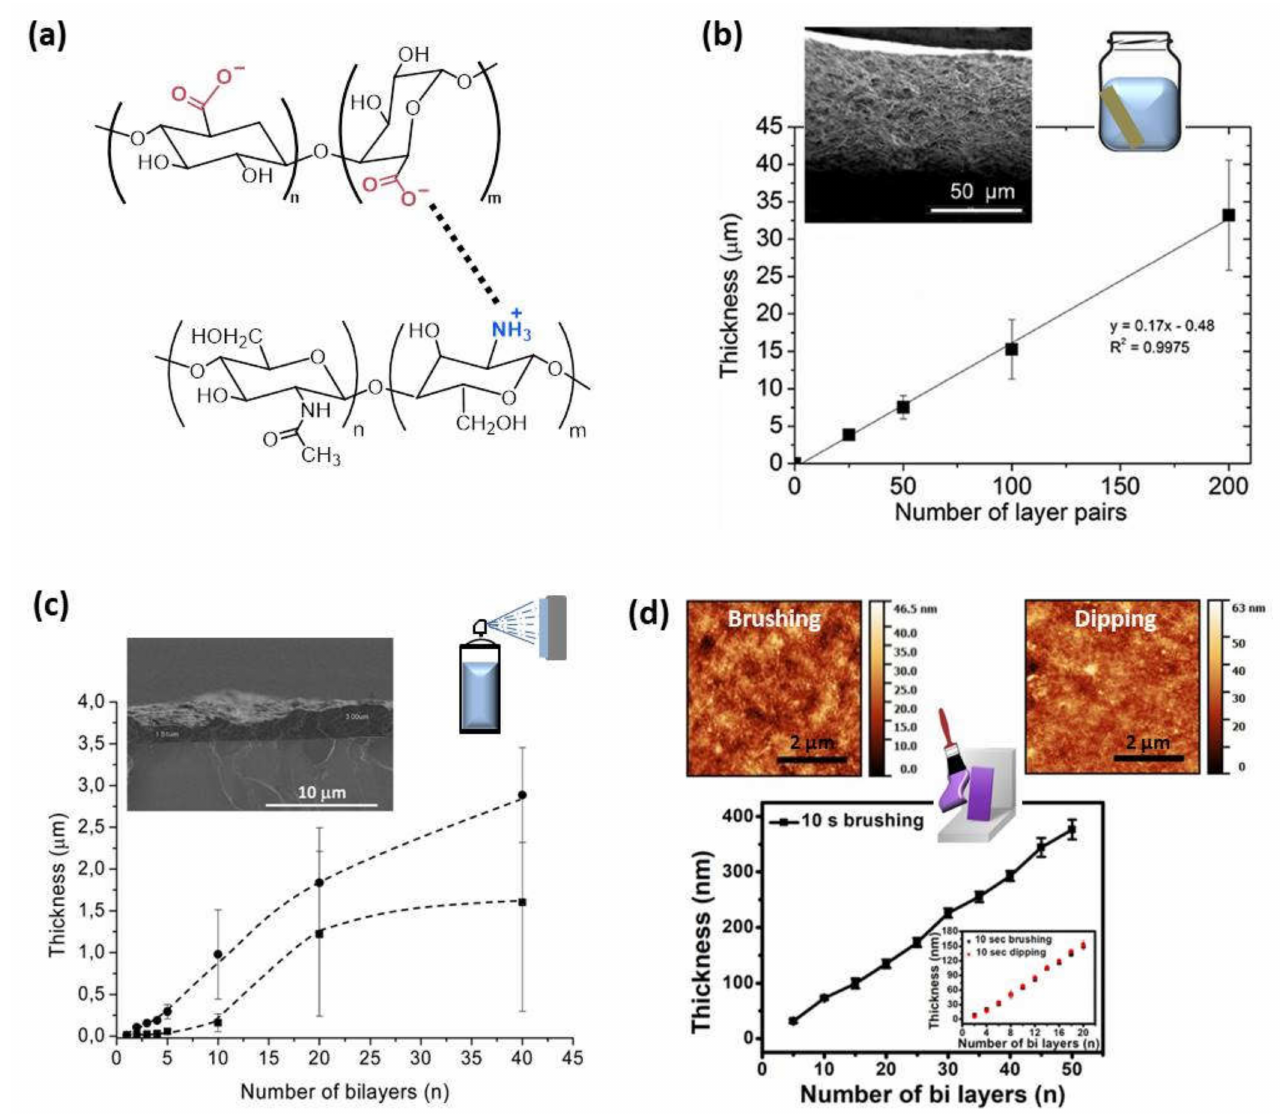
Figure 2. ( a ) Schematic representation of the electrostatic interaction between the protonated amine groups of chitosan and carboxylate groups of alginate; ( b ) Thickness of CHI/ALG films built up by dipping and a cross-sectional image via SEM (Adapted and reprinted with permission from [47]; Copyright 2013 American Chemical Society); ( c ) Evolution of the thickness of (ALG/CHI) n films with different ALG concentrations: 1 mg/mL ( (cid:4) ) and 2.5 mg/mL ( • ) measured by SEM. The inset of the figure is a representative SEM micrograph of a film’s cross-section (Reprinted with permission from [48]; Copyright 2016 American Chemical Society); ( d ) Growth thickness of CHI/ALG films assembled by brushing with a comparison of dipping and brushing methods in the inset and in the topographic AFM images (adapted and reprinted with permission from [33]. Copyright 2018, Kyungtae Park et al. Springer